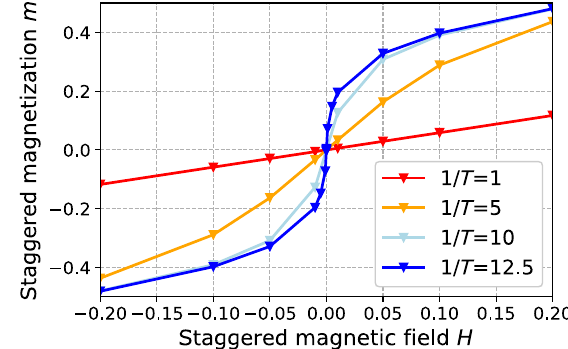
FIG. 34. Antiferromagnetic staggered magnetization m vs staggered applied field H in CDMFT on an 8 × 8 lattice for various